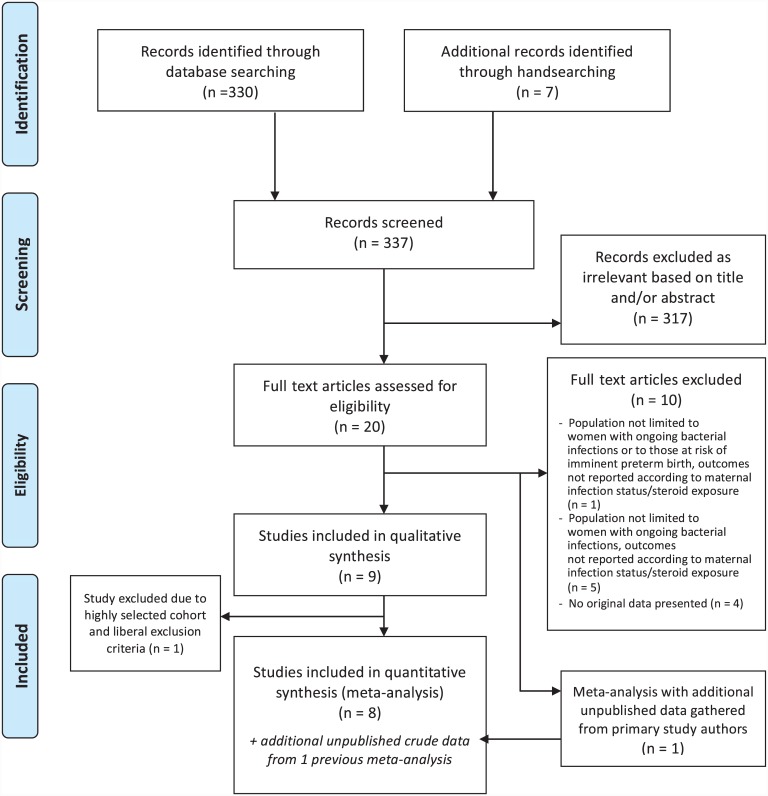
Flow diagram of search results and study selection for sub-question P3.